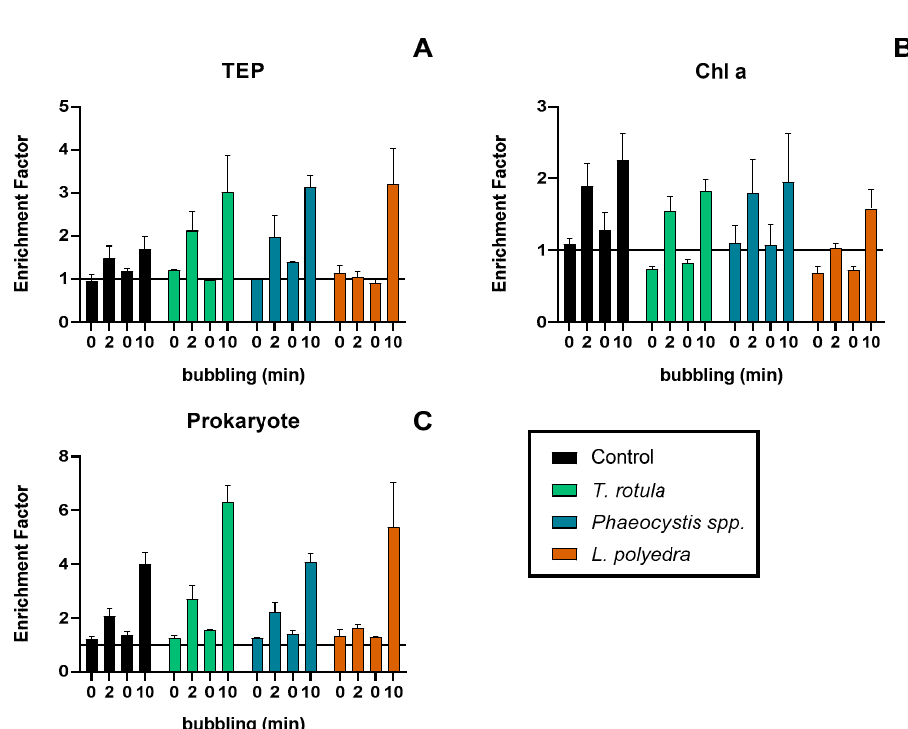
Figure 5. Results for the enrichment of TEP ( A ), Chl a ( B ) and Prokaryotes ( C ) from experiments using seawater spiked with different phytoplankton species. SML enrichment factors (enriched when EF > 1) from initial sampling (0), after 2 min bubbling (2), initial sampling again (0) and after 10 min bubbling (10). Note differing y -axis scales.